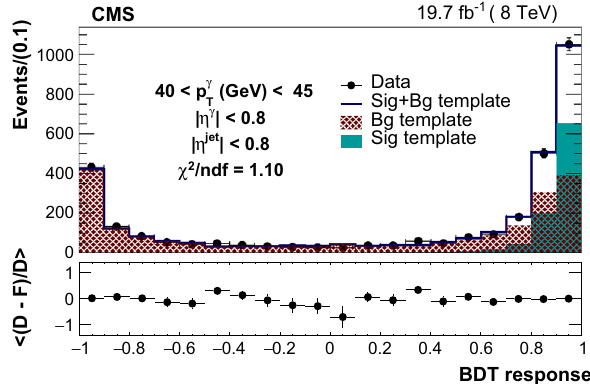
Fig. 1 An example fit of candidate boosted-decision-tree distribution with a composite template (blue histogram). The signal (background) template is shown by the green (red) solid (hatched) region. The bottom panel shows the mean of the fit values for 500 templates varied within the signal and background shape uncertainties (F) subtracted from data (D) divided by the data